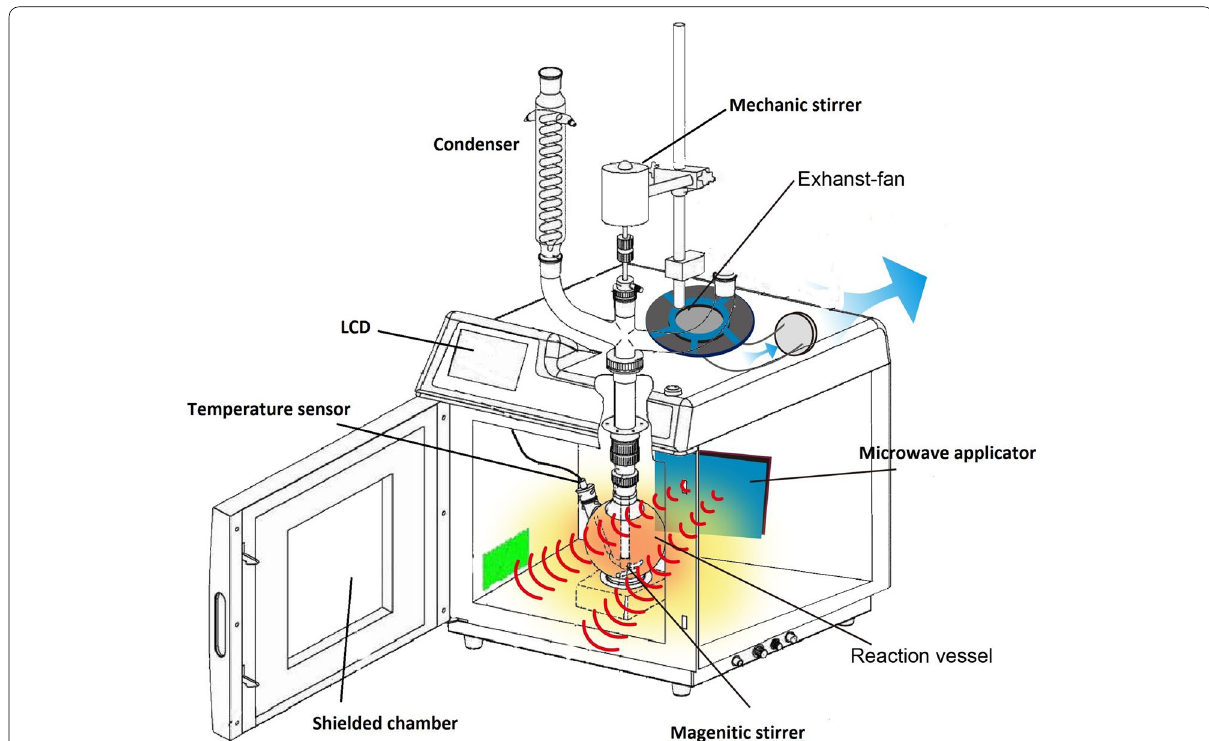
Fig. 1 Schematic diagram of the experimental setup (microwave system structure). (Reprinted with permission from Lin et al. [5]). Copyright (2020), Elsevier [License Number: